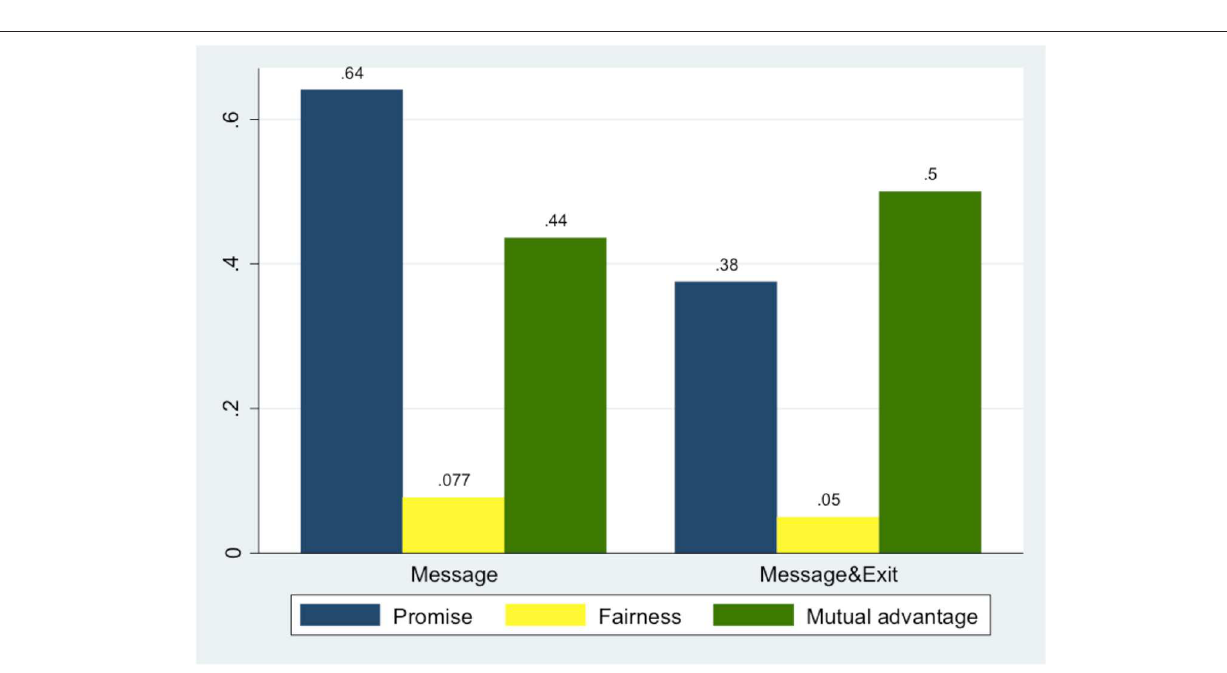
FIGURE 10 | Proportions of messages with different